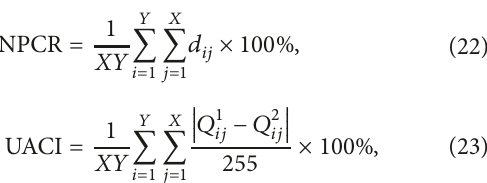
change) in a plain image can lead to a completely different encrypted